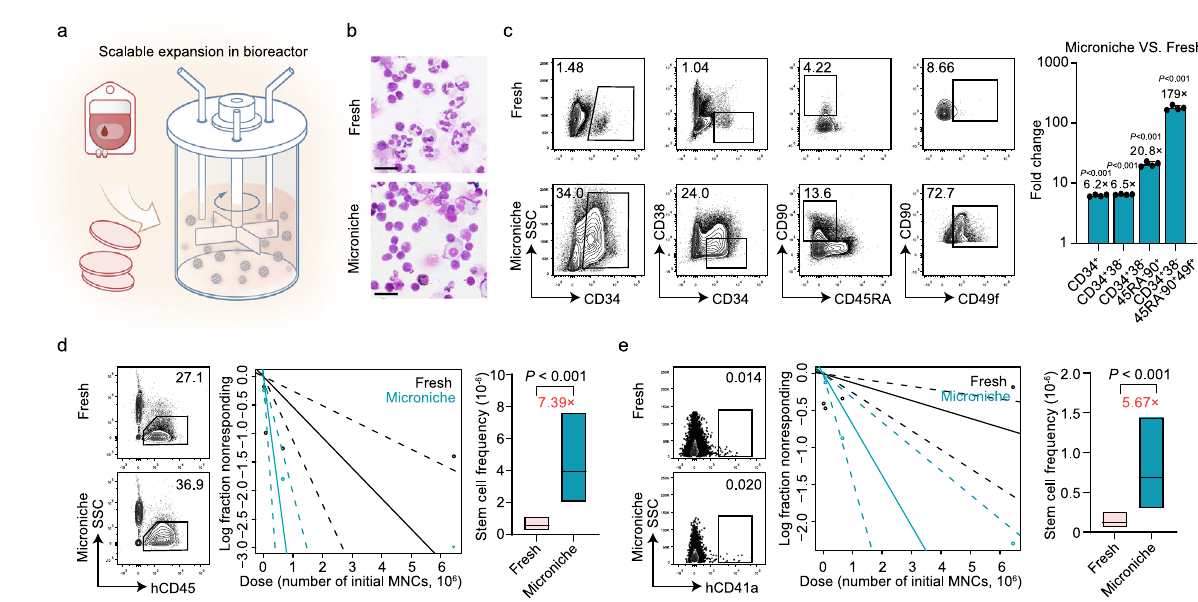
Fig. 3 | Large-scale dynamic bulk-culture with Microniche. a Schematic of HSC expansion using the biomimetic Microniche system in a large-scale, stirred bior- eactor. b Photomicrographs of Wright-Giemsa stained fresh UCB MNCs and cells after culture in a dynamic stirred Microniche-based bioreactor. Scale bar, 25 μ m. n =3 biological replicates, with similar results. c Representative FACS pro fi les and fold change of absolute counts of indicated UCB MNC subpopulations before (fresh) and after 3 days of expansion in a dynamic stirred Microniche-based bior- eactor. Fresh, n =4 technical replicates; Microniche, n =4 biological replicates. All data represent means±s.d.; unpaired two-tailed Student ’ s t test. d Representative FACSpro fi lesandstemcellfrequencybasedonthemCD45 − hCD45 + subpopulation